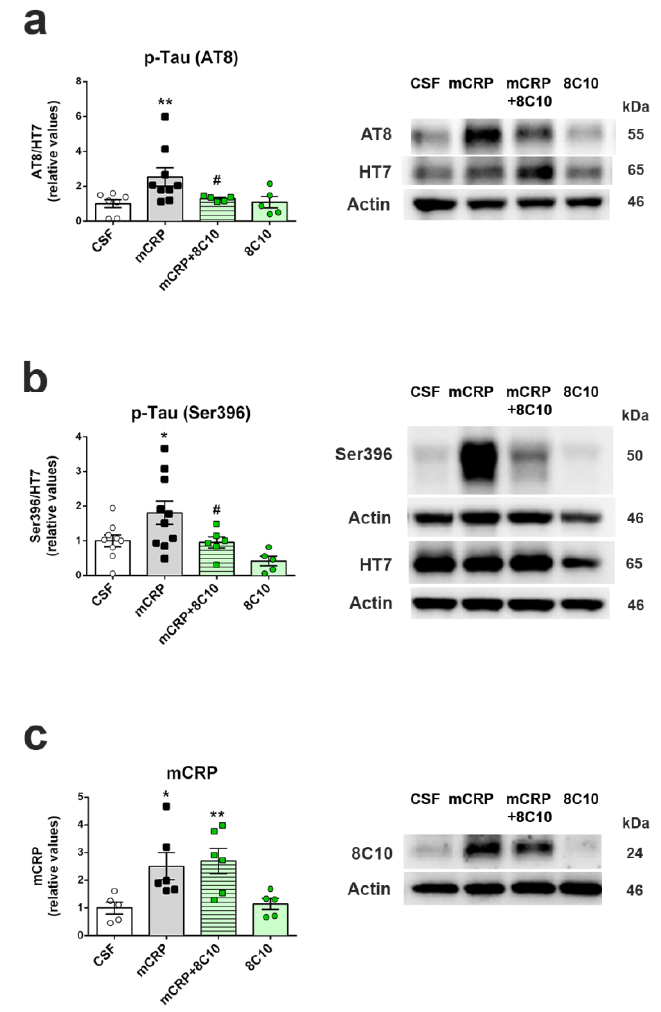
Figure 5. Tau pathology induced by mCRP was prevented by 8C10 antibody. Protein extracts of the whole hippocampus tissue showed higher levels of hyperphosphorylated tau (p-tau) after 6 months of mCRP treatment, but 8C10 prevented this pro-neurodegenerative change. Protein levels detected by p-tau antibodies AT8 ( a ) and Ser396 ( b ) were calculated as a ratio of the levels detected by total tau antibody HT7. ( c ) Protein levels of mCRP detected by 8C10 antibody in the hippocampus 6 months after the intrahippocampal injection were not decreased by co-treatment with 8C10. Representative blots of each experimental group are shown in the same order as the densitometric analysis values in the histograms. The images presented in this figure reproduce the cropped gels, while full-length gels are presented in Supplementary Figures S4, S5 and S8, respectively. Values are mean ± SEM (( a ) CSF N = 7, mCRP N = 9, mCRP + 8C10 N = 5 and 8C10 N = 5; ( b ) CSF N = 9, mCRP N = 10, mCRP + 8C10 N = 6 and 8C10 N = 5; ( c ) CSF N = 5, mCRP N = 6, mCRP + 8C10 N = 6 and 8C10 N = 6). Statistics: * p < 0.05, ** p < 0.01 compared to Control group; # p < 0.05 compared to mCRP group.